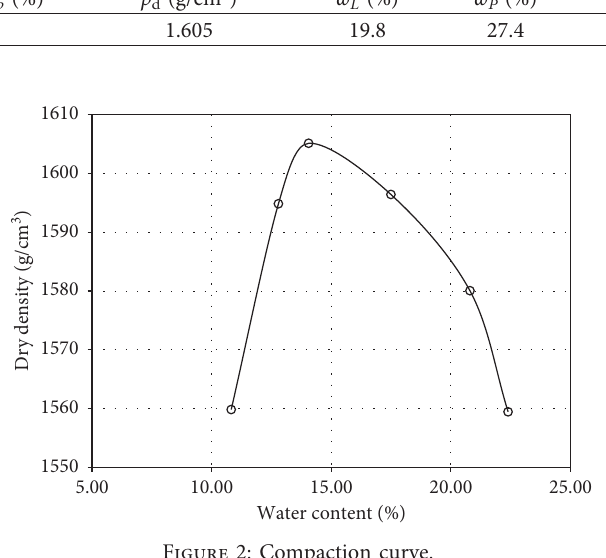
Figure 2: Compaction curve.